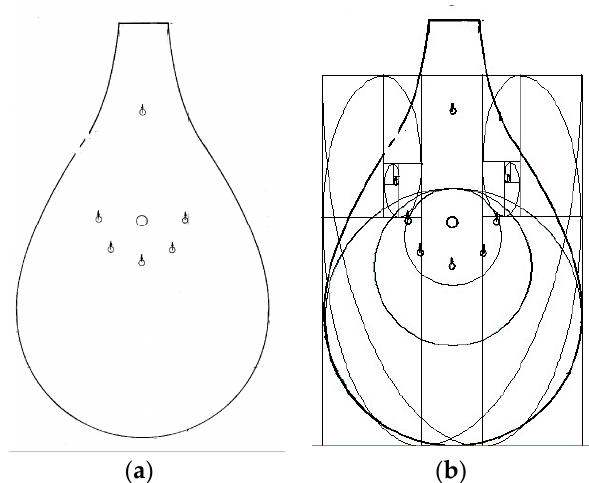
Figure 10. ( a ) Eshghi pattern, ( b ) Application of the Golden Method to the Eshghi.